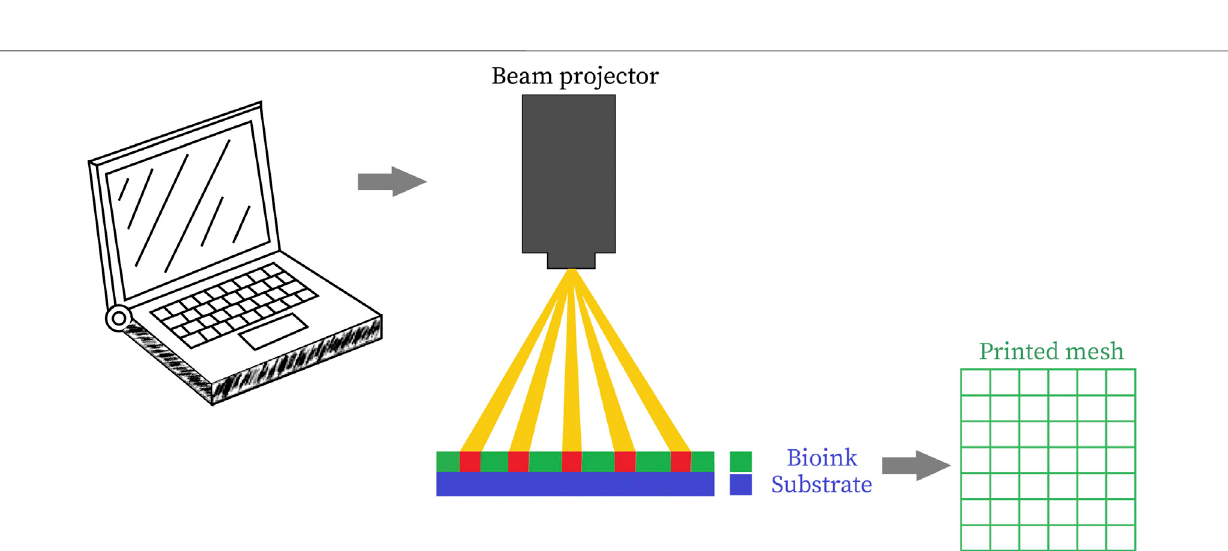
Frontiers in Mechanical Engineering |